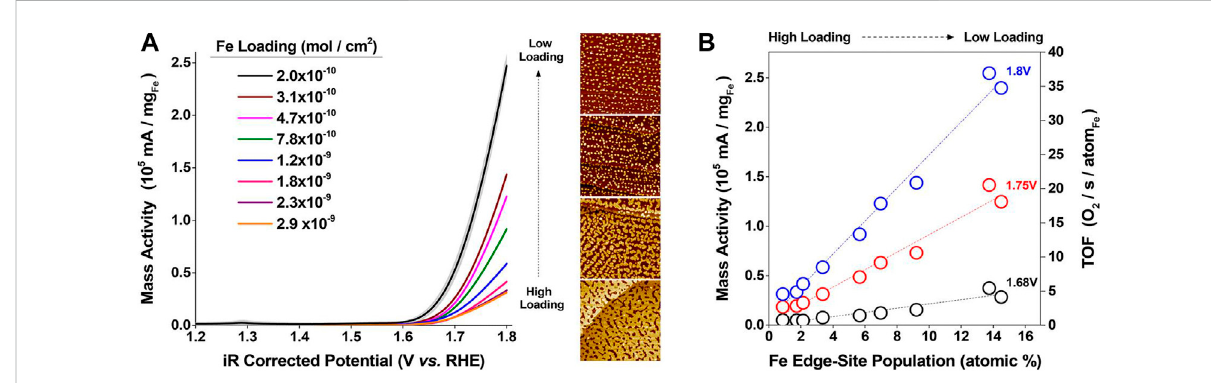
FIGURE 2 (A) OER voltammograms of 2L-Fe 2 O 3 /Au under different loadings in N 2 purged 0.1 M KOH (Kauffman et al., 2019). (B) TOF and mass activity versus the relative population of edge-site located Fe atoms (Kauffman et al., 2019). Copyright 2019, American Chemical